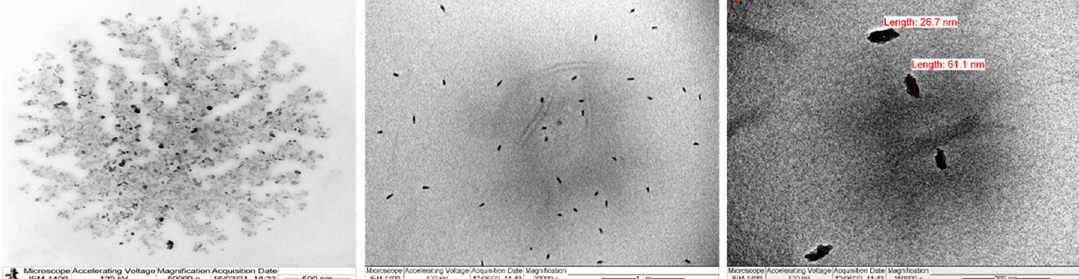
Figure 7. TEM images of Nanocellulose.